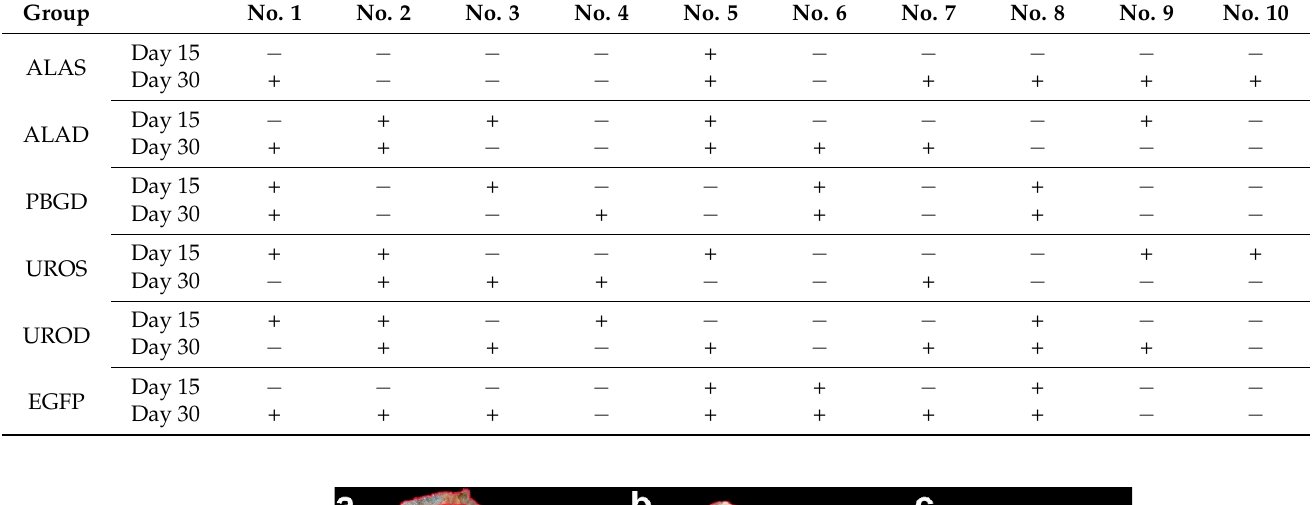
Table 1. Phenotypic change of C. gigas characterized by the whole orange shell after dsRNA interference (individual was denoted as − or + corresponding to showing the obviously newly deposited shell or not.). Group